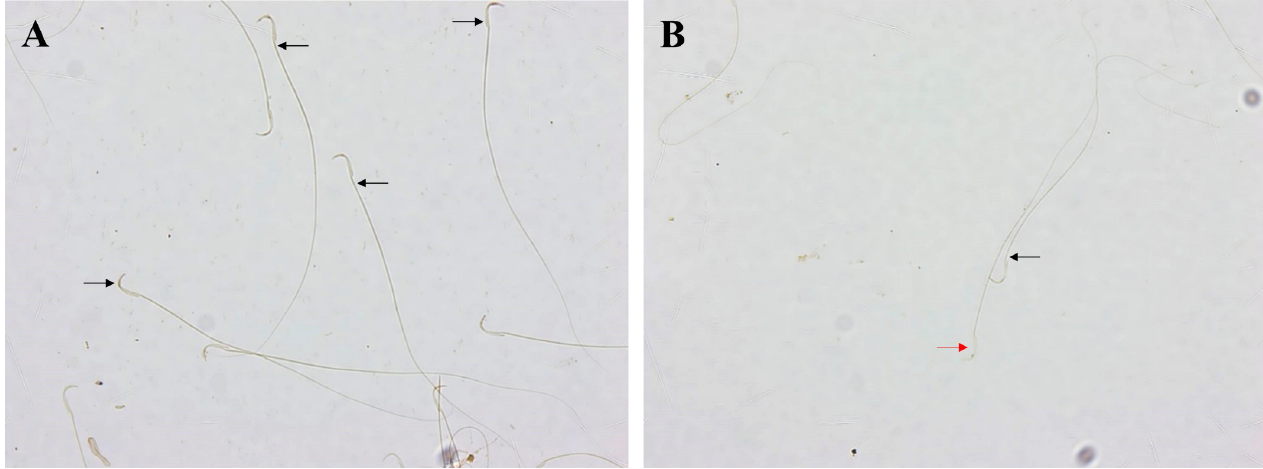
Fig 8. Negative-to-strongly-positive immunostaining for calbindin in rat epididymal spermatozoa at 200 × magnification. (A, B) Black arrows indicate the strong-positively stained sperm. (B) A red arrow indicates a negatively stained spermatozoon.